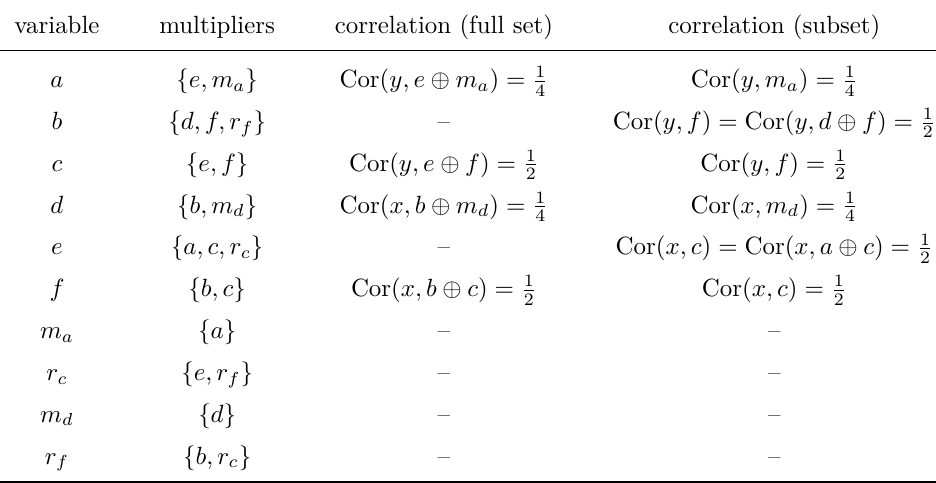
Table 1: Multipliers for each variable in AND gadget of